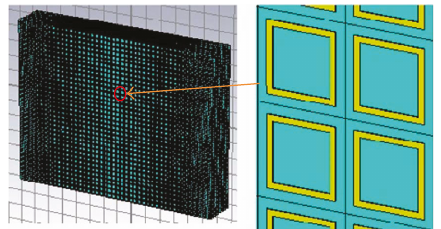
Figure 5: CSR array and unit cell.